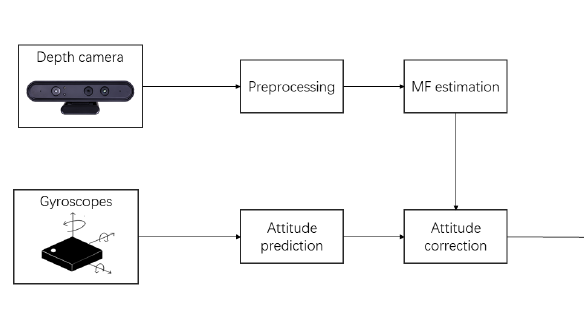
Figure 1. The overview of our proposed indoor attitude estimation method using gyroscopes and depth sensors. In summary, the key contributions of this work are as